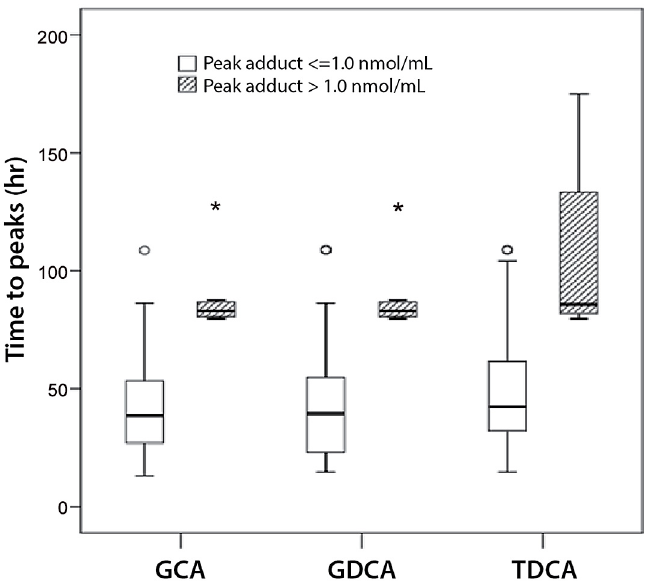
Fig 1. Comparison of time to reach peak bile acid, presented as a function of peak APAP protein adduct < or (cid:1) 1.0 nmol/mL APAP protein adduct. * denotes > 2.0 times the 25 – 75 th percentile; O denotes > 1.5 times the 25 – 75 th percentile. GCA, Glycocholic acid; GDCA, Glycodeoxycholic acid; TDCA, Taurodeoxycholic